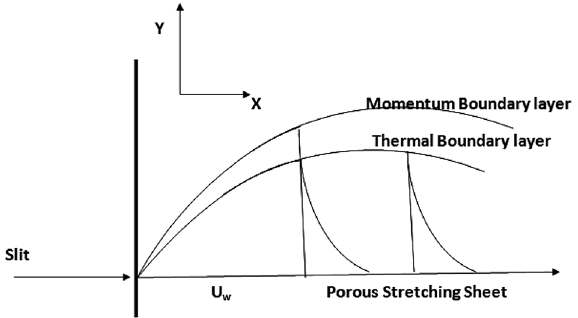
Figure 1. Flow geometry of the